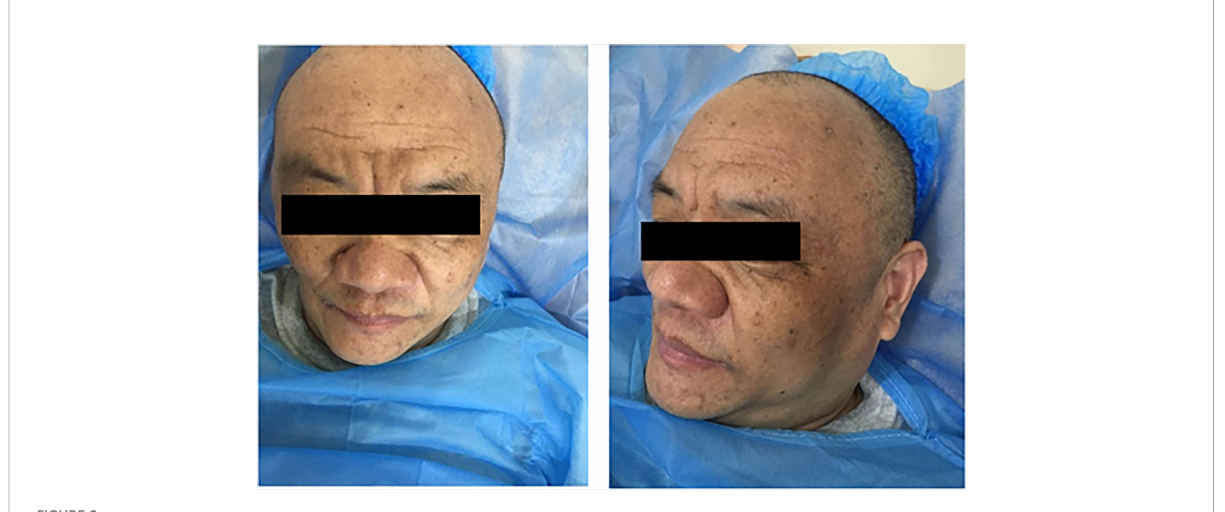
FIGURE 2 Facial changes of the patient, including acrochordons and